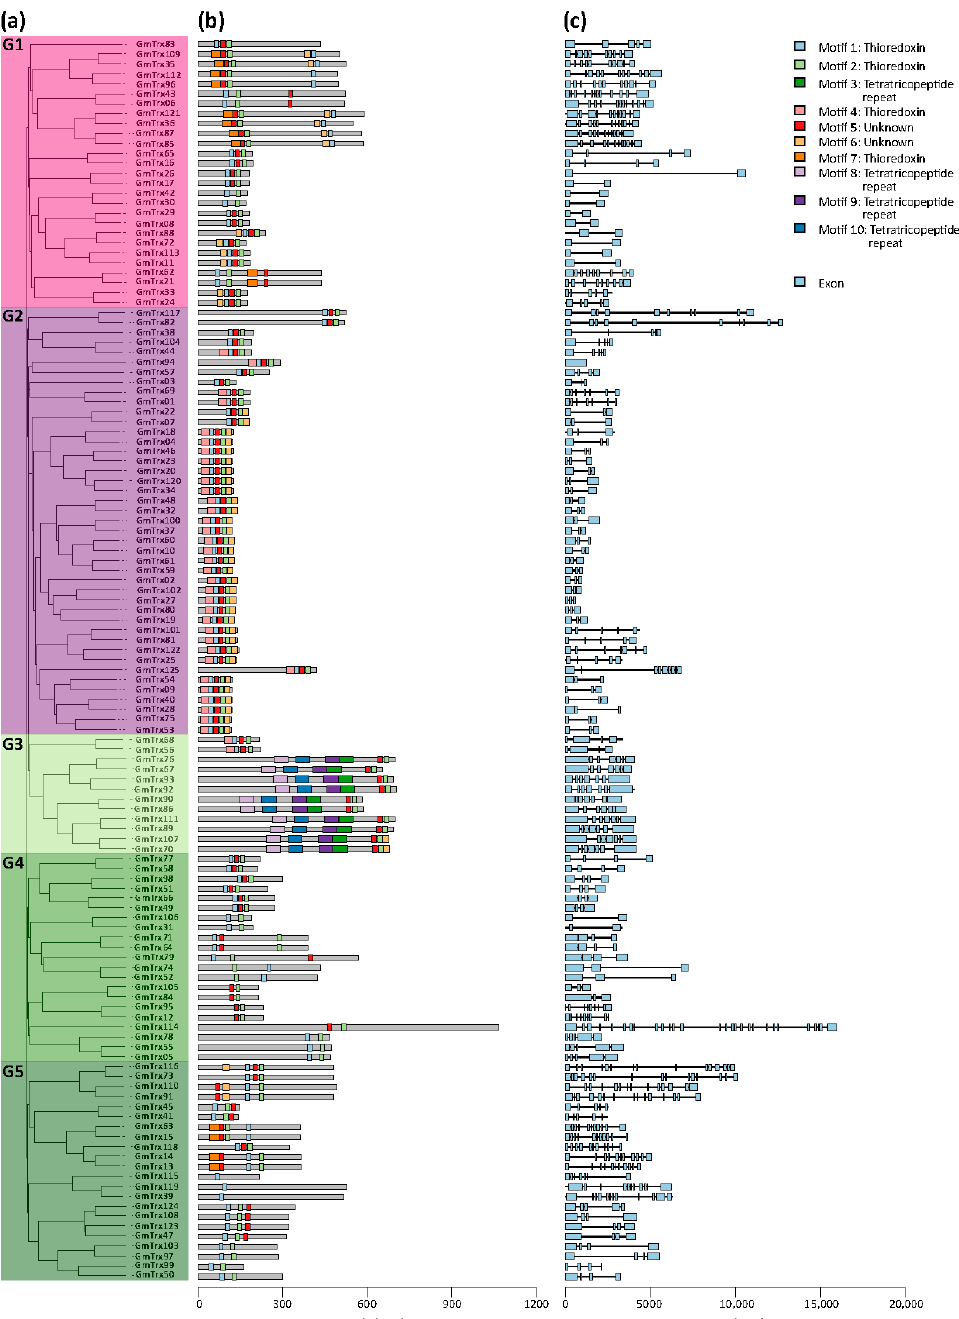
Figure 2. Phylogenetic tree, conserved motif, and gene structure of Glycine max Trx genes ( GmTrx ). ( a ) Phylogenetic relationship among the GmTrx based on the amino acid sequence alignment. ( b ) Conserved motifs in amino acid sequence of different subgroups of GmTrx. The different colored boxes on the right represent diverse conserved motifs. The general characteristics of the motifs can be found in Table S3. ( c ) Exon–intron analysis of GmTrx genes.